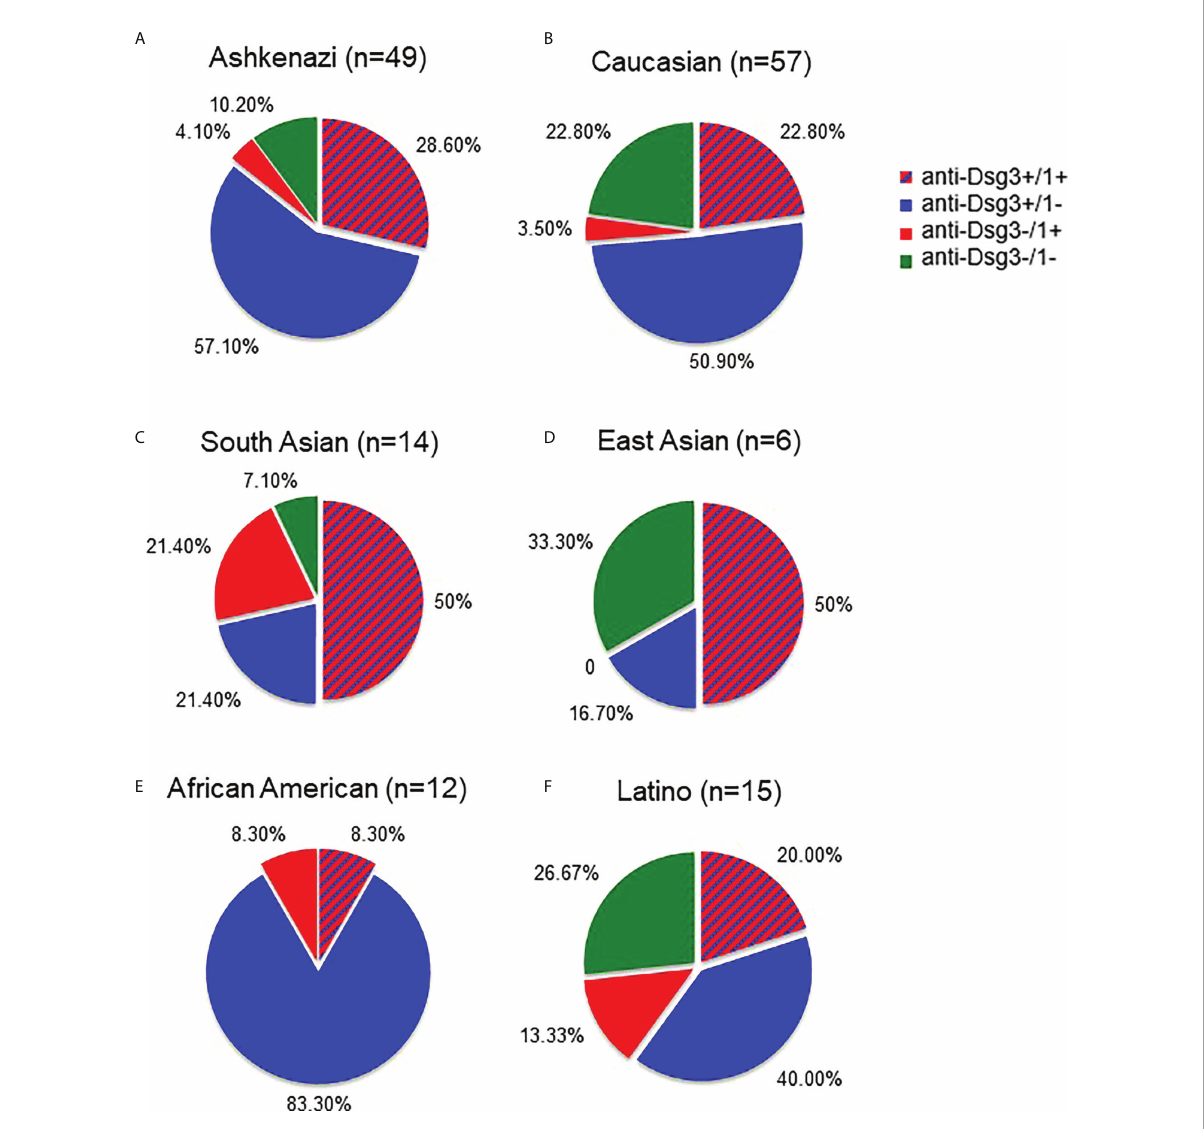
FIGURE 3 Autoantibody pro fi les differ between Ashkenazi and non-Ashkenazi ethnicities. We compared the anti-Dsg3/1 autoantibody pro fi les of all active PV subjects according to their self-identi fi ed ethnicity. The Ashkenazi Jewish population (A) was found to have a predominantly anti-Dsg3 + /1 - pro fi le. The Caucasian population (B) showed a similar pro fi le to that seen in the Ashkenazi ethnicity, though with slightly less anti-Dsg3 + /1 - and greater anti-Dsg3 - /1 - percentages. The South Asian (C) antibody pro fi le showed a greater proportion of anti-Dsg3 - /1 + (21.4%) with a greater total percentage of total anti-Dsg1 + (71.4%) than seen in the Ashkenazi and Caucasian populations (32.7% and 26.3%, respectively). Additionally, the East Asian population (D) shows predominantly anti-Dsg3 + /1 + and anti-Dsg3 - /1 - patterns. The African American population (E) shows a largely anti-Dsg1 - /3 + pro fi le. The Latino population (F) shows a relatively even distribution across anti-Dsg patterns, with slightly more anti- Dsg3 + /1 -